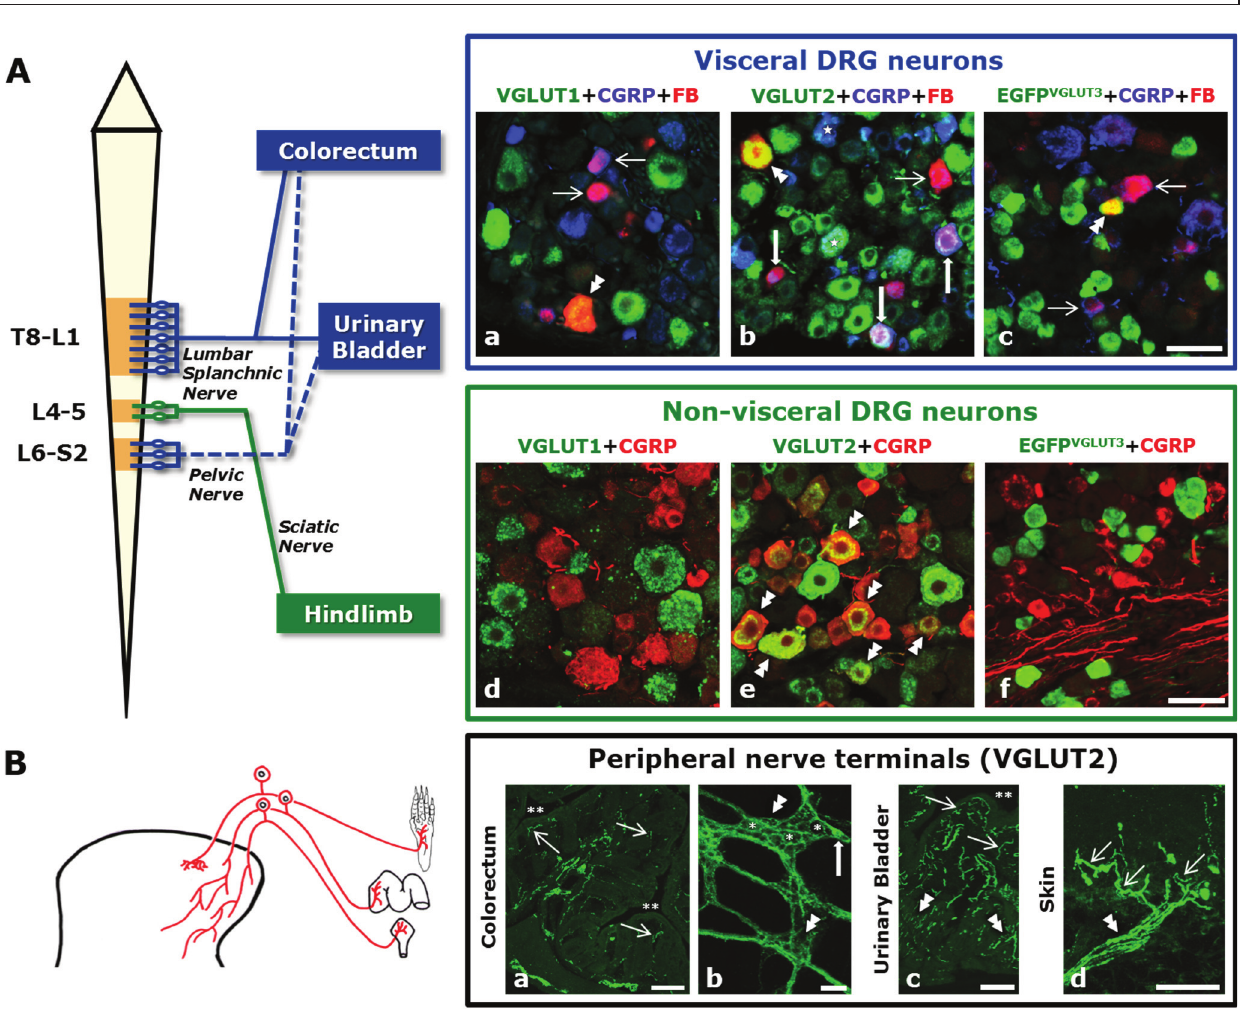
Figure 1. ( A ) (Left panel) Schematic diagram showing the spinal cord and the dorsal root ganglia (DRG) levels involved in the formation of the lumbar splanchnic, pelvic, and sciatic nerves. Colorectum and urinary bladder are examples of visceral pelvic organs